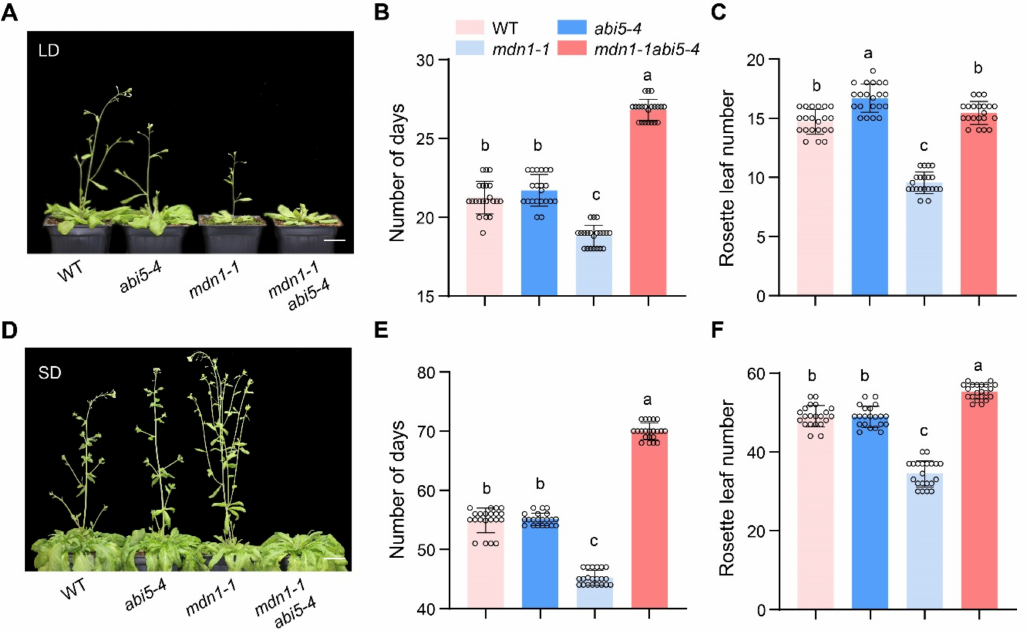
Figure 6. abi5-4 inhibits the early flowering of mdn1-1 . ( A ) abi5-4 , mdn1-1 and mdn1-1 abi5-4 grown in LD. ( B , C ) The number of days and rosette leaf number at the flowering in LD. ( D ) abi5-4 , mdn1-1 and mdn1-1 abi5-4 grown in SD. ( E , F ) The number of days and rosette leaf number at the flowering in SD. Twenty plants per line were scored. One-way ANOVA was employed, and the lowercase letters denote distinct groups ( p < 0.01). Scale bars, 2